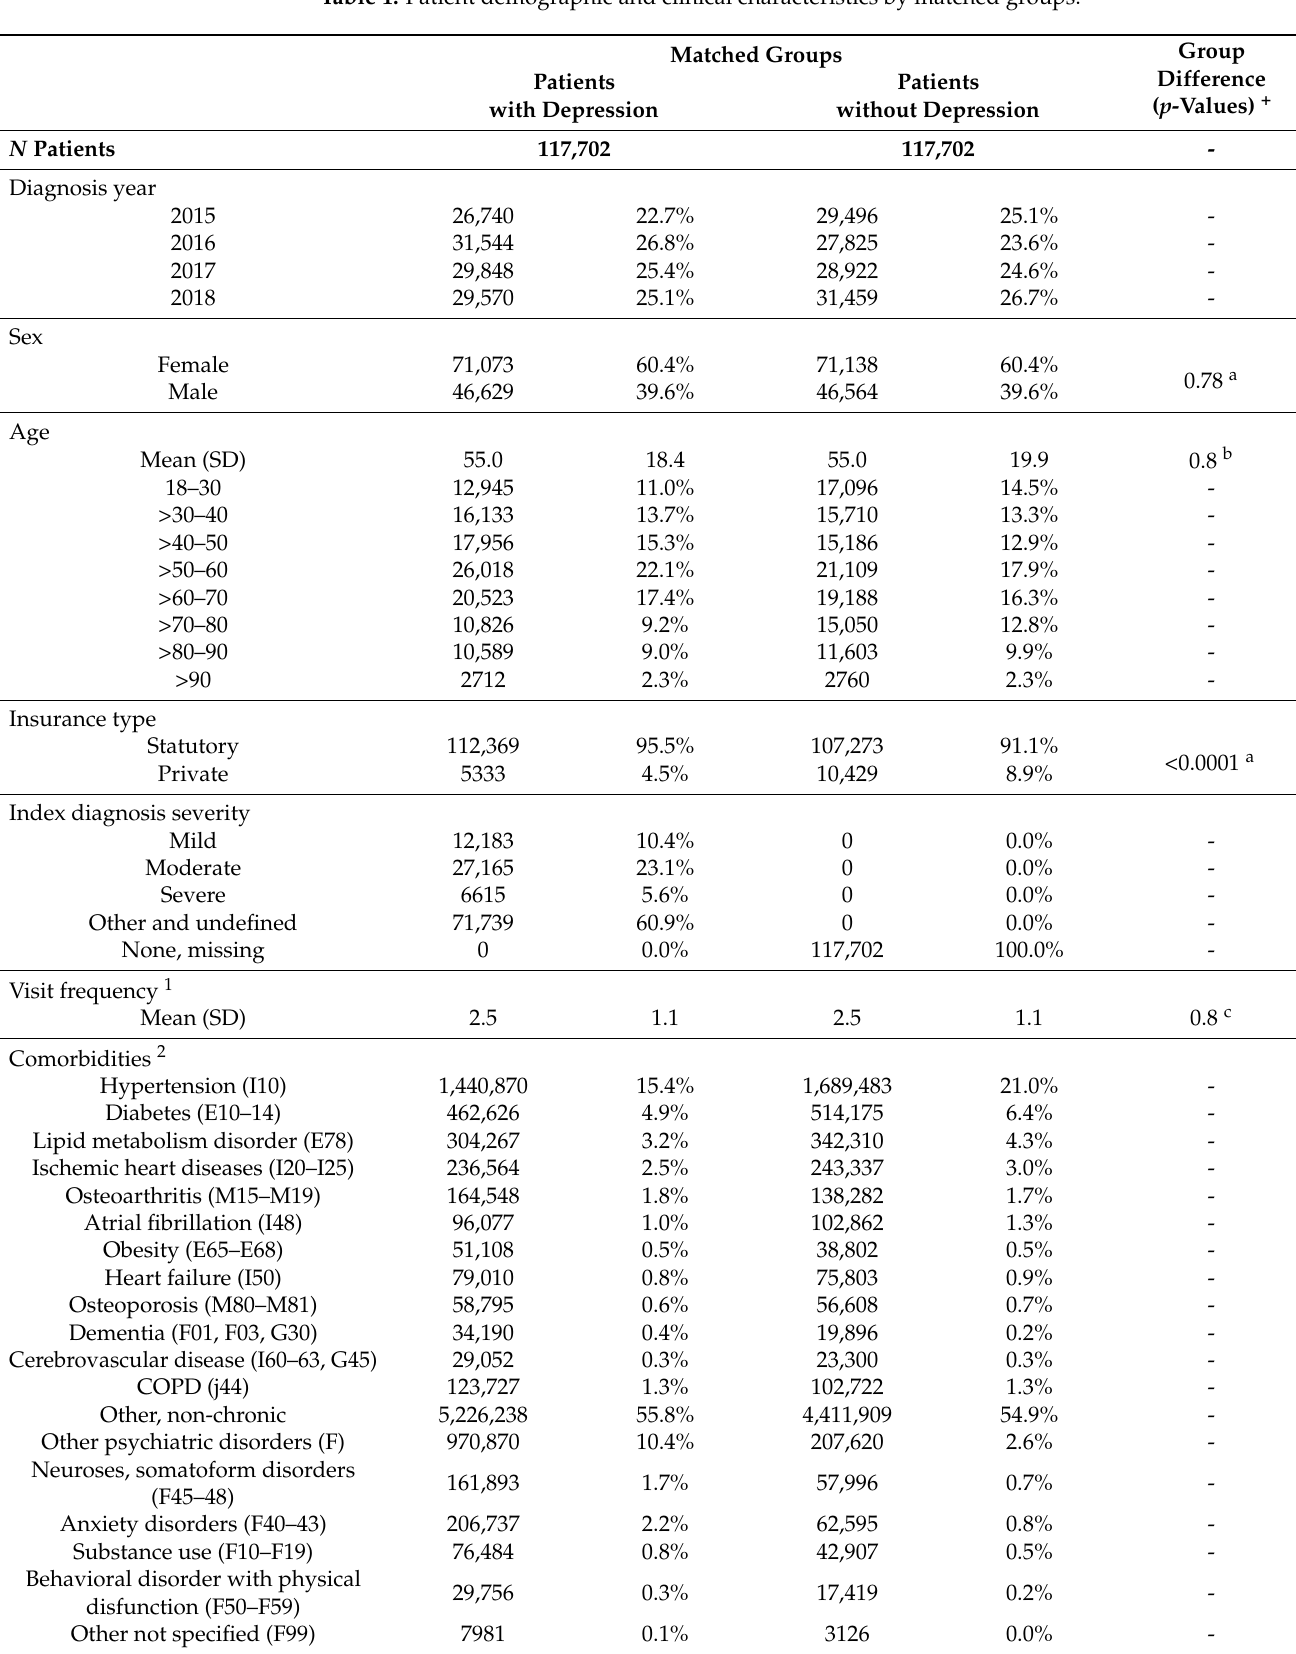
Table 1. Patient demographic and clinical characteristics by matched